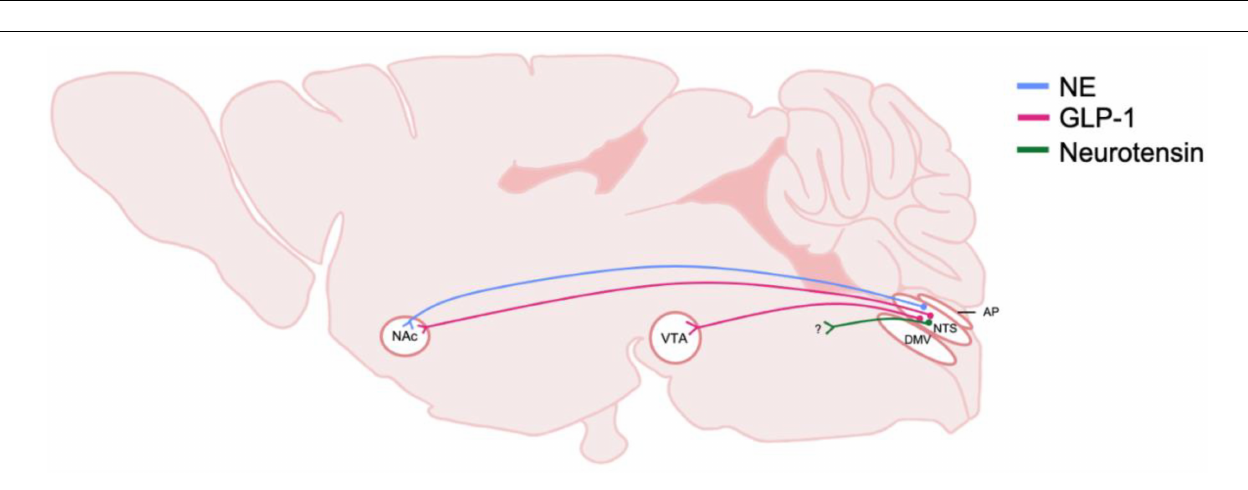
FIGURE 3 | Schematic of DVC projections hypothesized to be involved in central stress systems and AUD. The origin and distribution of DVC neurotransmitter and peptide pathways involved in stress and implicated in AUD. Peptide and transmitter systems include NE, norepinephrine; PrRP, prolactin releasing peptide; GLP-1, glucagon-like peptide 1; GABA, gamma-aminobutyric acid. Dotted lines indicate that projections have been identified, but functionality and relevance to AUD is not known. Note that most of these projections arise from the caudal NTS, nucleus of the tractus solitarius. Also, efferent motor projections from the DMV, dorsal motor nucleus of the vagus nerve, are included to highlight their importance in physiological responses to stress in AUD. BNST, Bed nucleus of the stria terminalis; PVN, paraventricular nucleus of the hypothalamus; CeA, central amygdala; AP, area postrema.